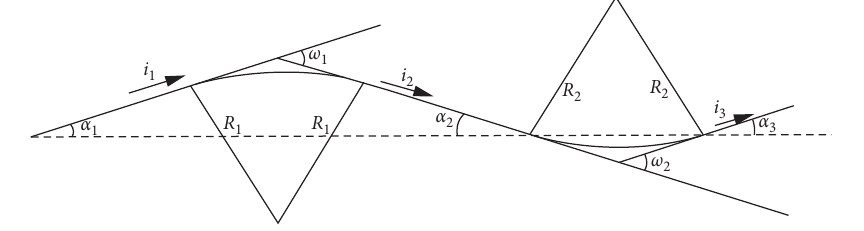
Figure 2: Convex and concave vertical curves.